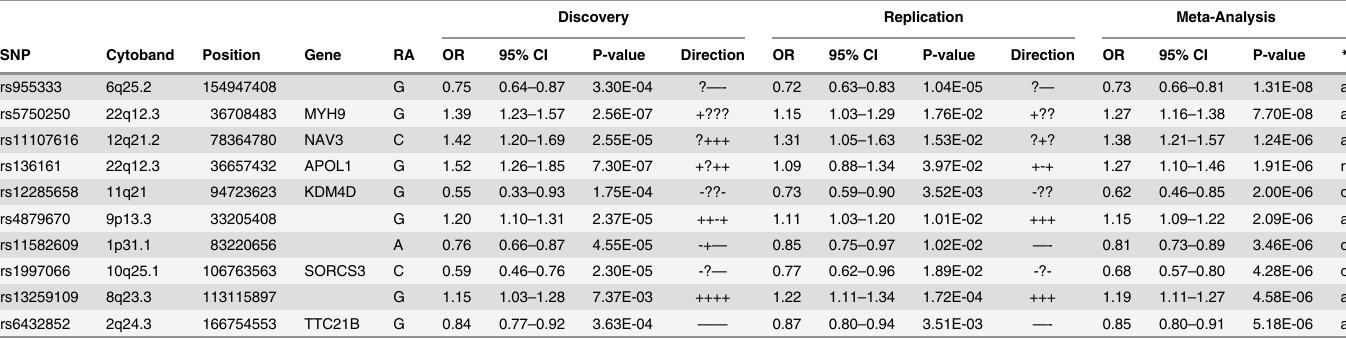
Table 2. Trans-ethnic meta-analysis GWAS results, across Discovery and Replication